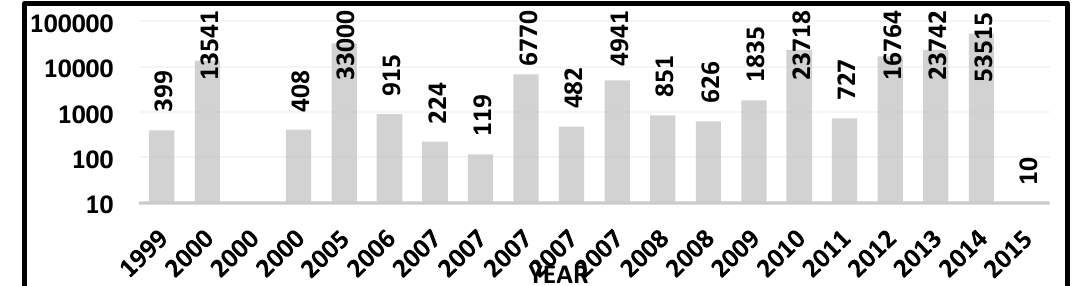
Fig.1. Year Vs No. of sample